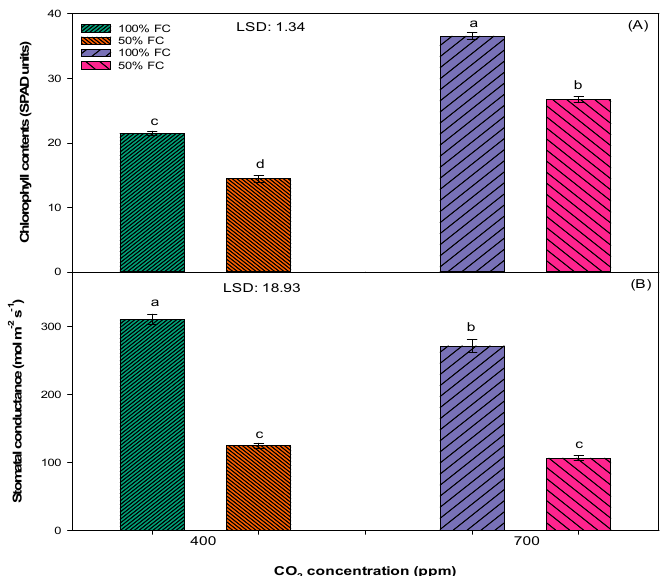
Figure 4. Effect of different [CO 2 ] and soil moisture levels on ( A ) chlorophyll content (SPAD value) and ( B ) stomatal conductance of S. cannabina . The experiment was repeated, and the pooled data from the two studies are presented here. The plotted data represent the combined data set of two experiments. The vertical bars represent error bars ( n = 12). LSD represents the least significance difference ( p ≤ 0.05; n = 12). Different letters (a, b, c, d) on the error bars indicate significant differences, as determined by Fisher’s protected LSD test at p < 0.05. The abbreviation FC in the figure represents the field capacity.